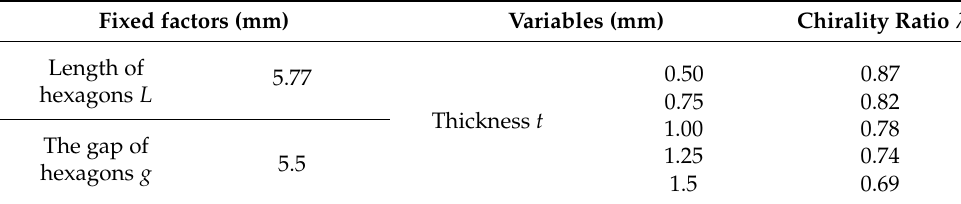
Table 1. Design parameters of the chiral